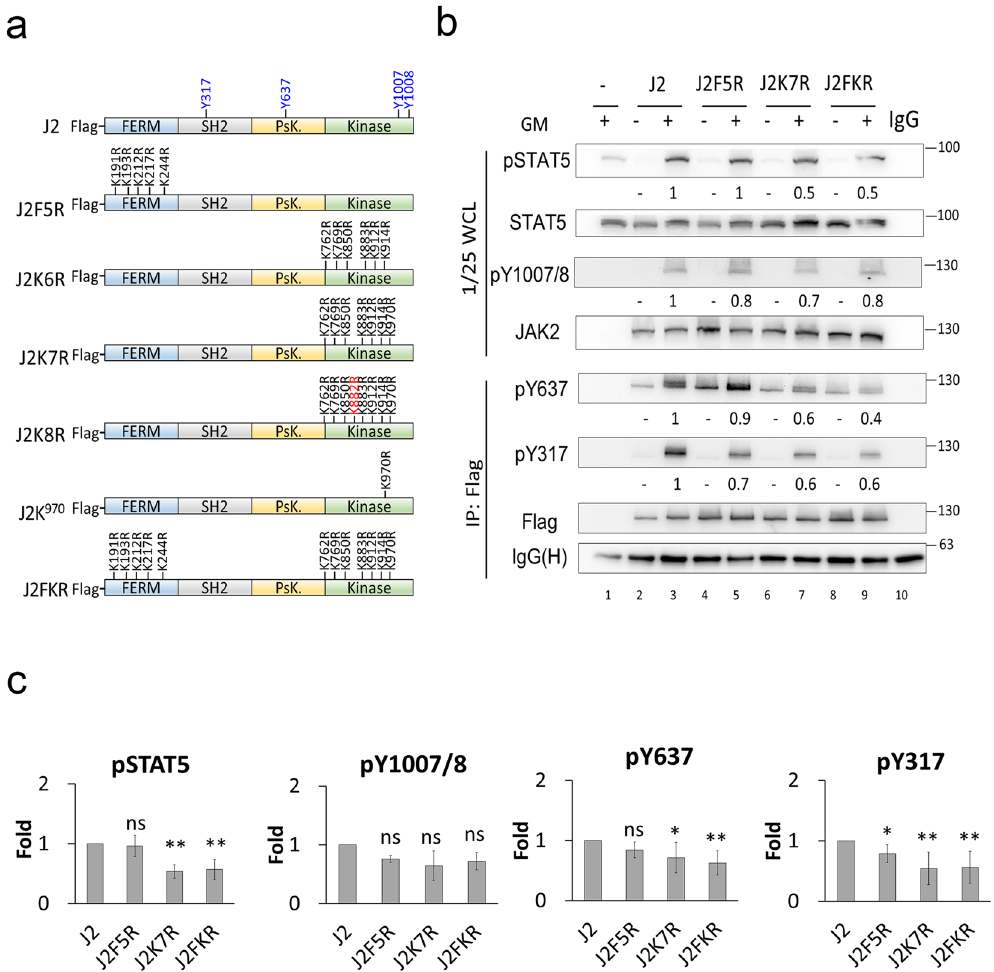
Figure 6. Ubiquitination of the kinase domain plays an important role in JAK2/STAT5 signal axis. ( a ) Schematic representation of KR mutants in the FERM and/or kinase domain of JAK2 that were used in the following experiments. Several important tyrosine residues that are phosphorylated during JAK2 activation are indicated in blue in the top panel. The kinase-dead JAK2 mutant (K882R) is marked in red. ( b , c ) Ubiquitination of the kinase domain is involved in cytokine-triggered JAK/STAT signaling. JKO cells were transfected with the indicated Flag-tagged JAK2 KR mutants (as shown in Fig. 6a), and, after overnight serum starvation, transfected cells were treated ( + ) or not treated ( − ) with GM-CSF (GM) (1 ng/mL) for 10 min. The WCLs were either analysed directly by Western blotting for levels of phospho-STAT5, total STAT5, phospho-JAK2 (Y1007/1008), and total JAK2, or were subjected to IP with an anti-Flag affinity gel and the IPs were probed for JAK2 phosphorylation at Y637 and Y317, as well as for Flag and IgG (b, lower panel). The phosphorylation levels on JAK2 and STAT5 shown in ( b ) were quantified and data are presented as means ± SEM from five independent experiments relative to WT JAK2 control, which was set as “1” ( c ). Statistical significance ( * P < 0.05 and ** P < 0.01) was determined by t-test. IgG(H): IgG heavy chain. WCL: whole cell